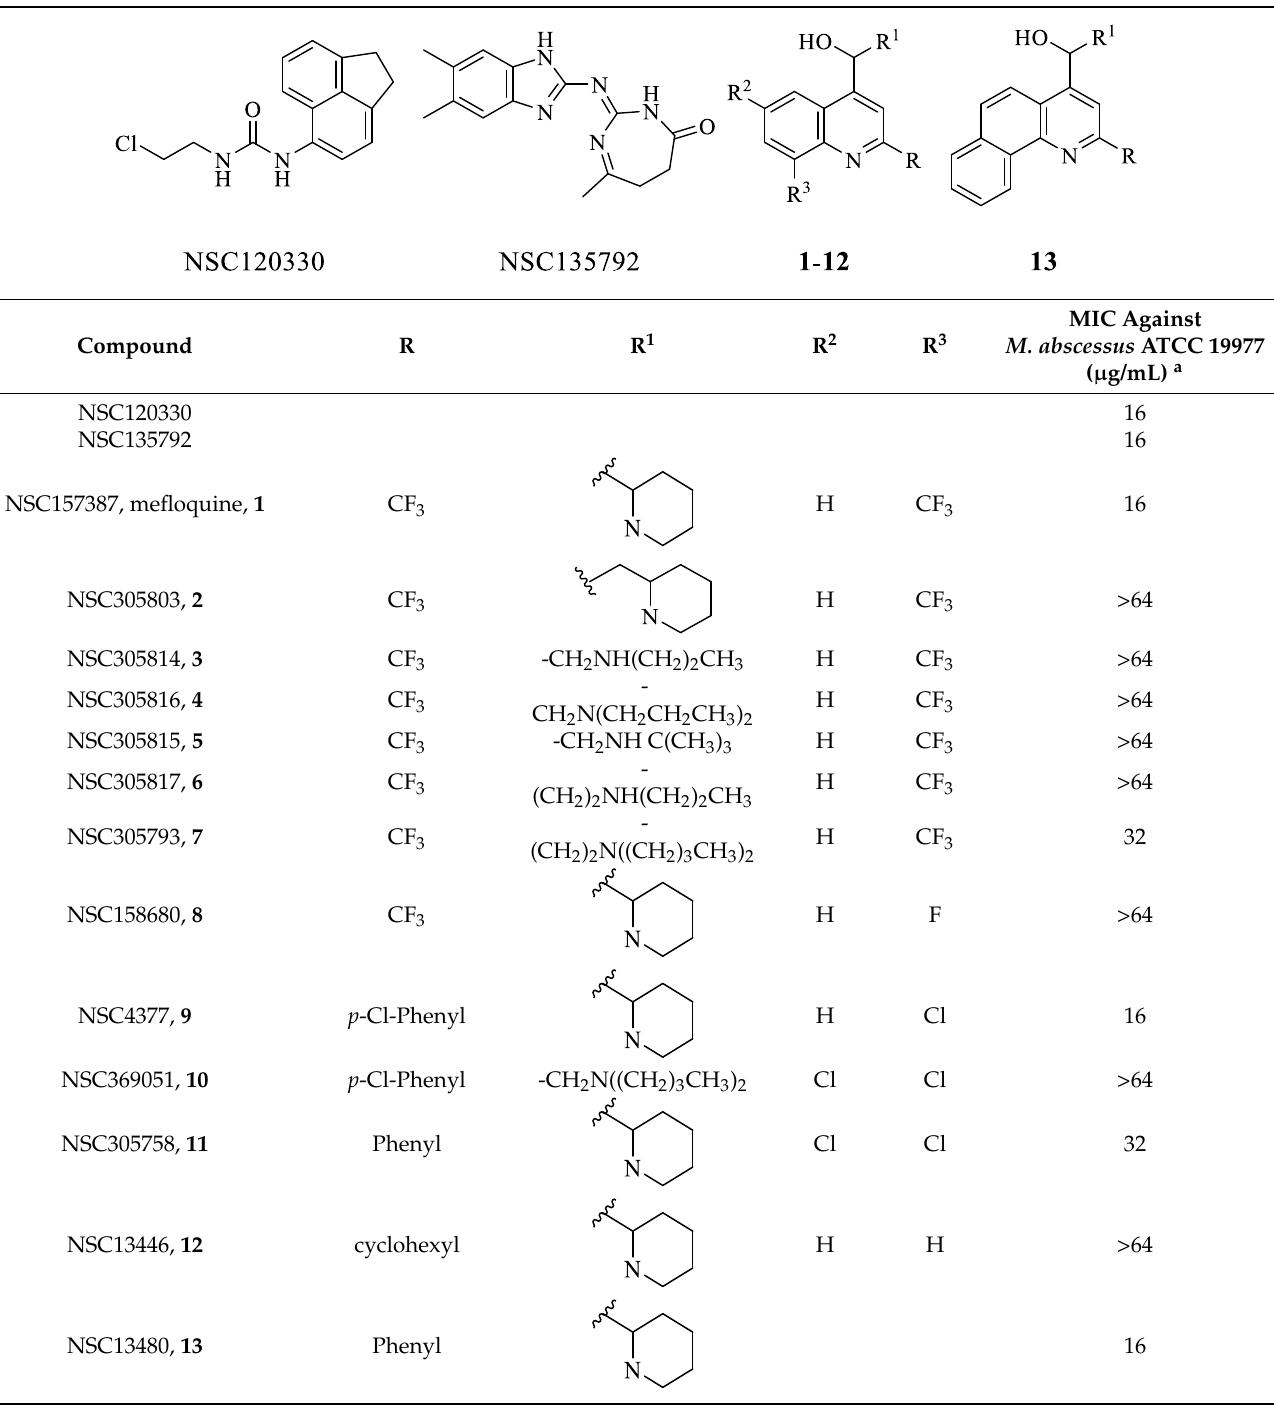
Table 1. Structure and anti- Mab activity of 3 active MmpL3 ligands and their analogs.